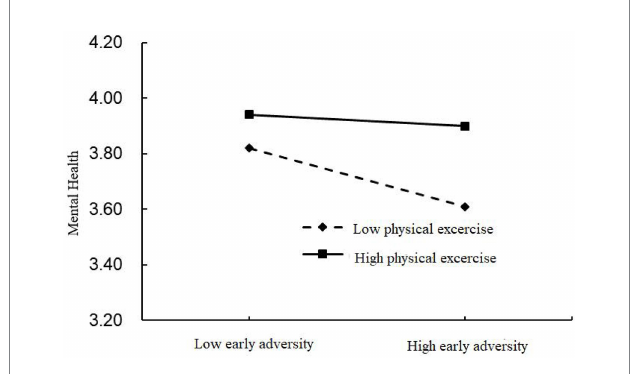
FIGURE 1 Moderating effects of physical